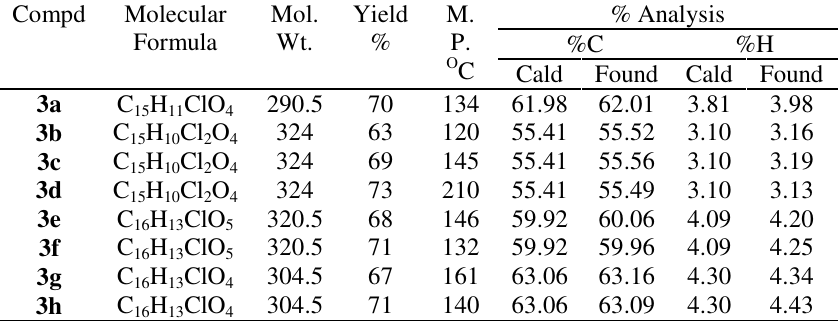
Table 2. The physical and analytical data of Compounds 3a-h Compd Molecular Formula